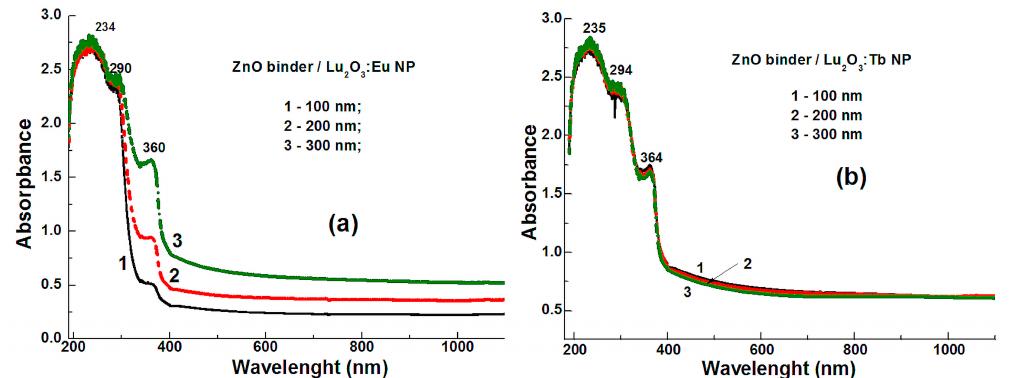
Figure 3. Absorption spectra of Lu 2 O 3 :Eu ( a ) and Lu 2 O 3 :Tb ( b ) films with thicknesses of about